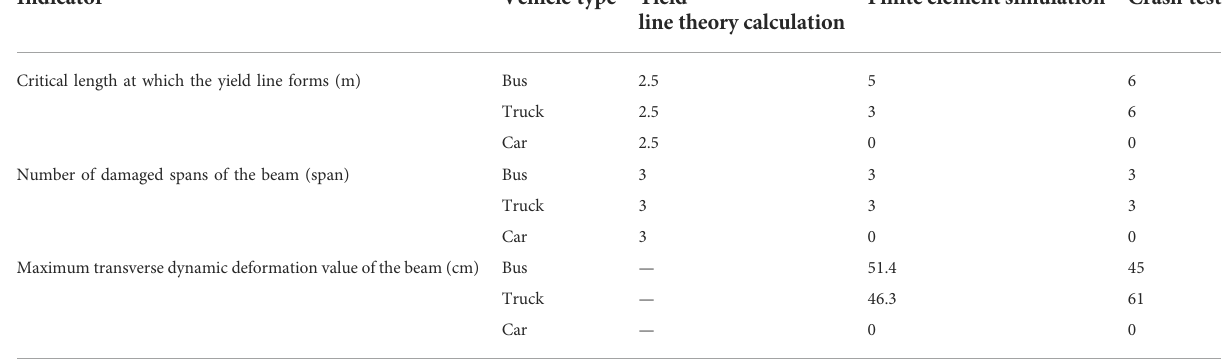
TABLE 2 Comparative analysis of the three veri fi cation methods. Indicator